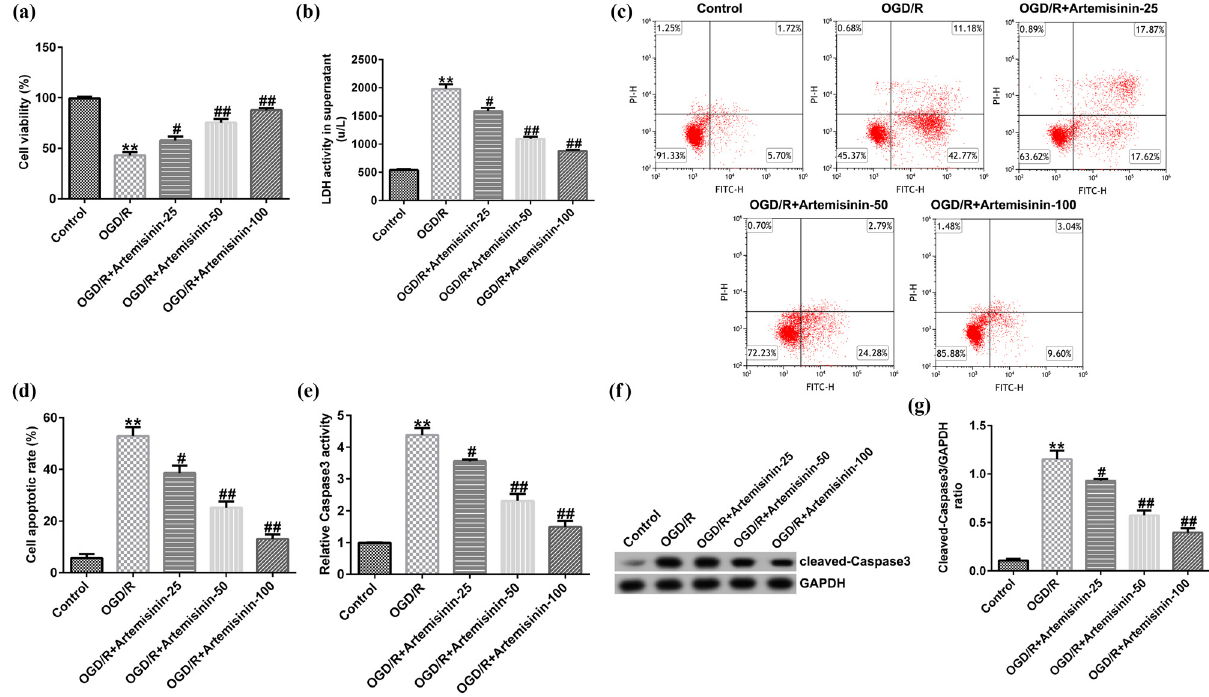
Figure 2: ART increases the viability and reduces apoptosis of hypoxia - glucose deprivation and reoxygenation ( OGD/R )- exposed SH - SY5Y cells in a dose - dependent manner. SH - SY5Y cells were pre - treated with the indicated concentrations of ART ( 0, 25, 50, and 100 μ M ) for 2 h and then exposed to OGD/R. ( a ) Viability of SH - SY5Y cells was determined using an MTT assay. ( b ) LDH activity was measured using an LDH assay kit. ( c and d ) Cell apoptosis was detected via fl ow cytometry. ( e ) Caspase - 3 activity was measured using a caspase - 3 activity detection kit. ( f ) Cleaved caspase - 3 protein detection was detected using western blotting. ( g ) Cleaved caspase - 3/GAPDH ratio. ** p < 0.01 vs Control; #,## p < 0.05, 0.01 vs